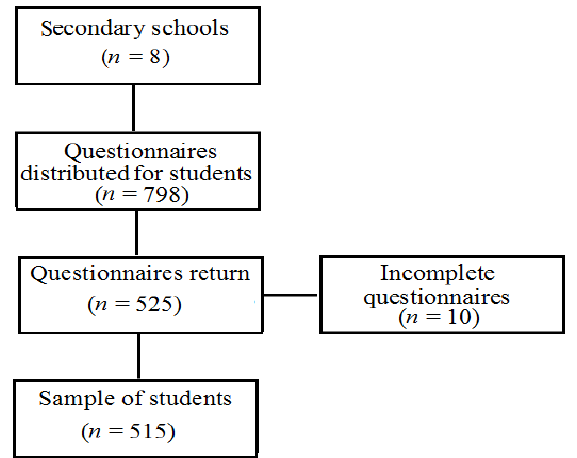
Figure 1. Scheme of the students’ sample ( n = 515).